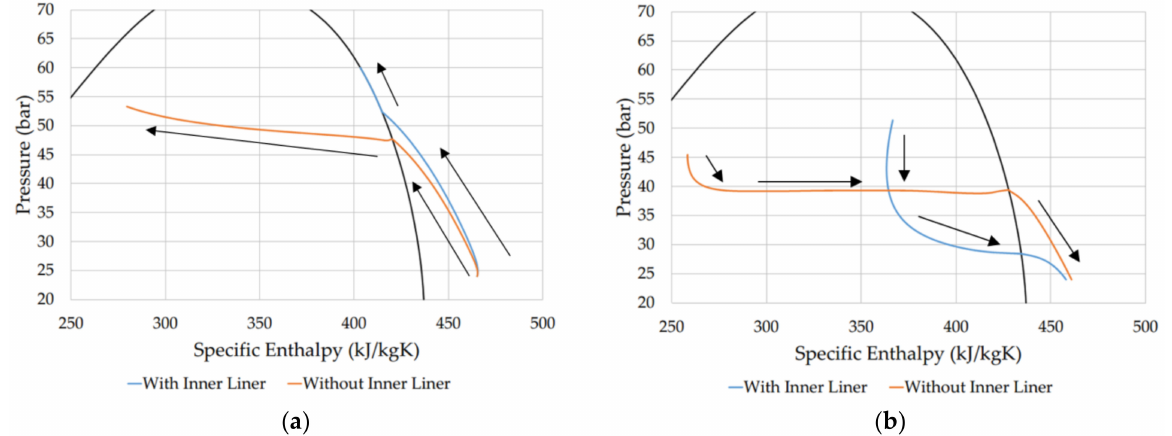
Figure 8. Pressure (bar) against specific enthalpy (kJ/kg · K) for the accumulator utilizing CO 2 for ( a ) charging stage and ( b ) discharging stage, with the black lines representing the liquid–vapor dome for CO 2 and the arrows indicating direction of the stage.